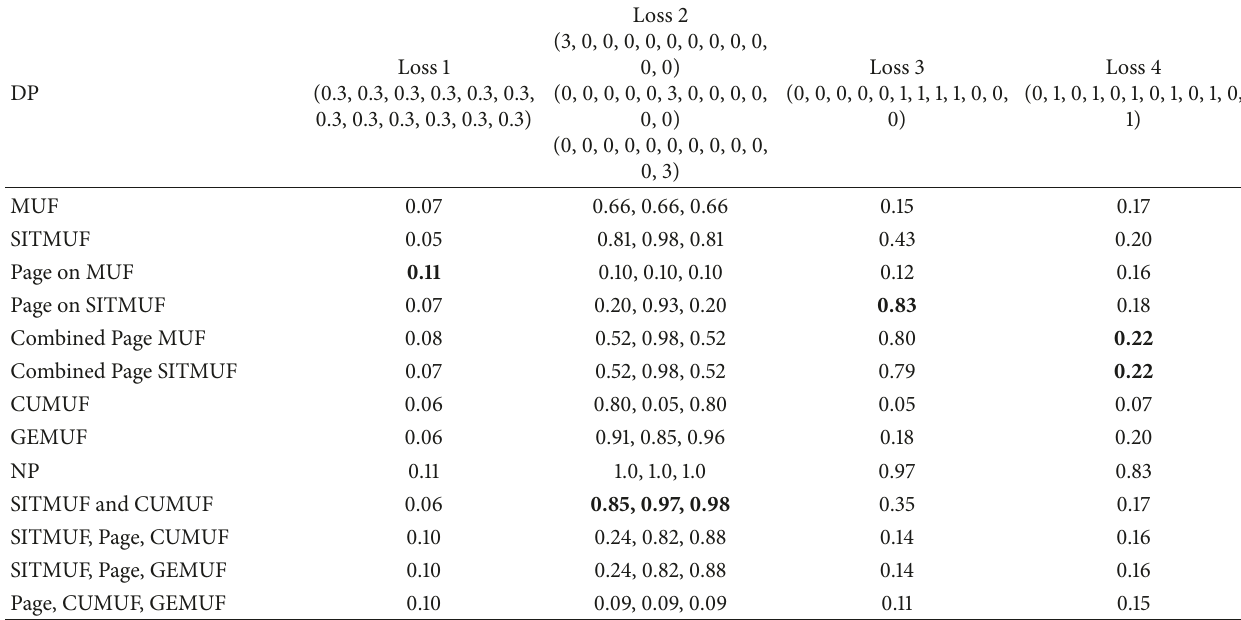
Table 3: DPs for Σ 3